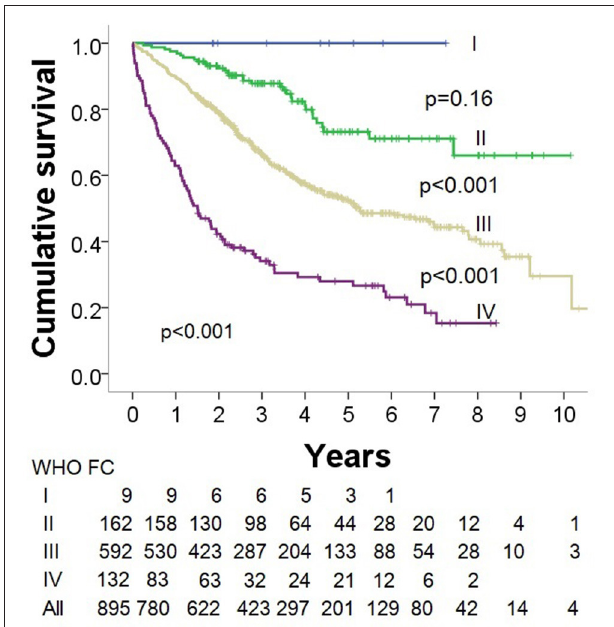
FIGURE 6 | Kaplan Meier survival analysis by World Health Organisation functional class.